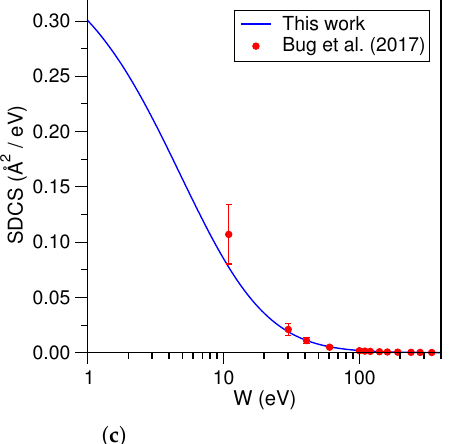
Figure 10. Electron-impact SDCS for pyrimidine at a primary electron energy of ( a ) T = 80 eV, ( b ) T = 300 eV, and ( c ) T = 1000 eV. The solid lines are the present results, and the filled circles are the experimental points derived by Bug et al. [59].